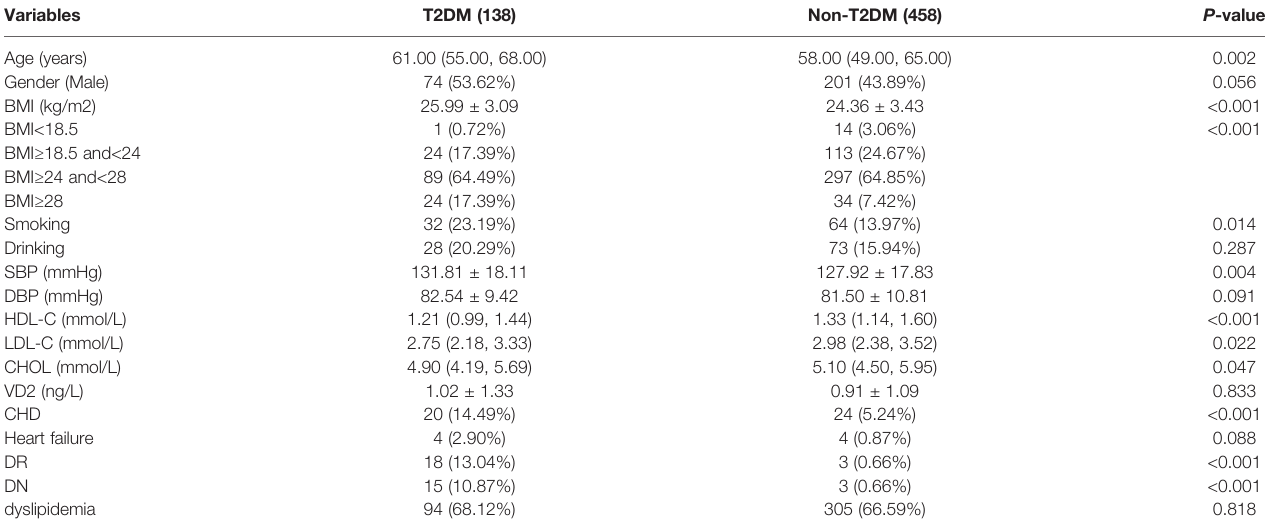
TABLE 1 | Clinical and biochemical characteristics of participants according to the occurrence of T2DM.